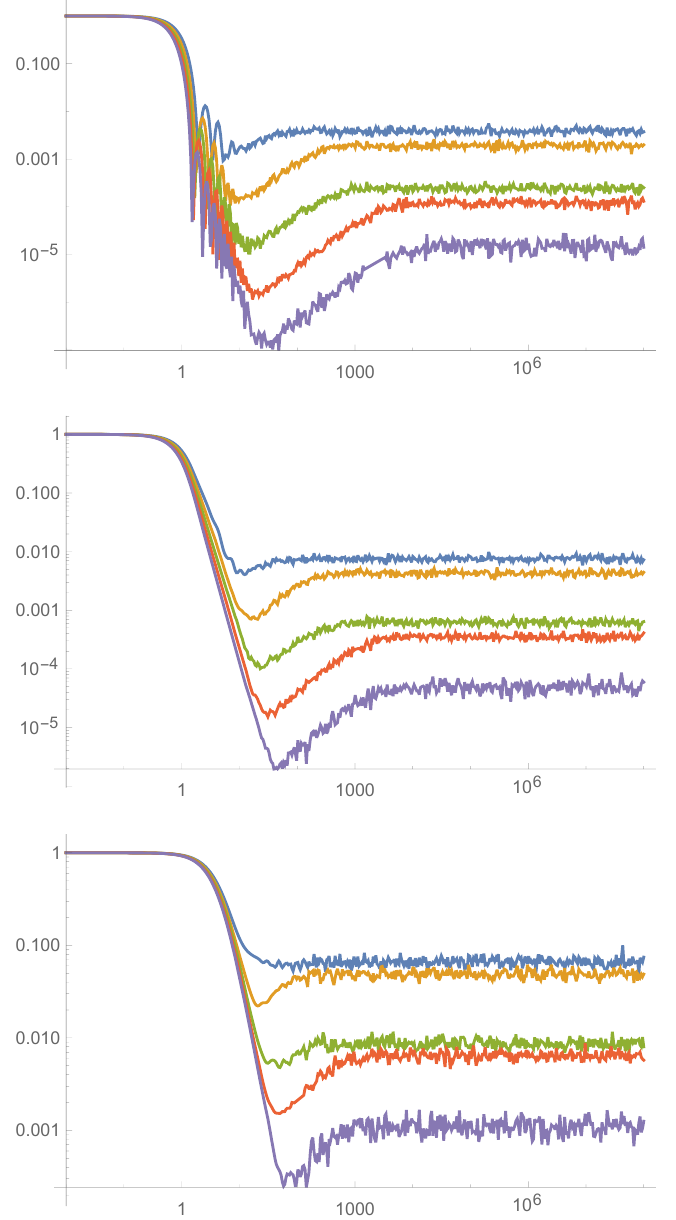
Figure 5 . The SFFs for the generalized SYK model; the values of N are 16 (blue line), 20 (yellow line), 24 (green line), 28 (red line) and 32 (violet line). Top: (cid:12) = 0, center: (cid:12) = 1, bottom: (cid:12) =